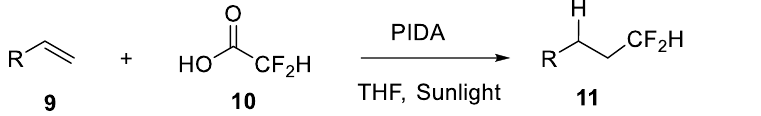
Figure 2. PIDA-mediated radical pathway for the synthesis of 3-alkylquinoxalin-2(1 H )-ones. (b) C-C bond formation reaction on alkenes